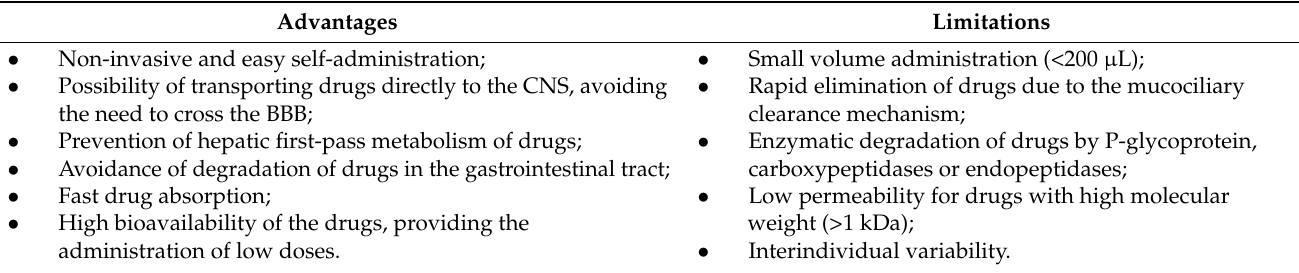
Table 2. Main advantages and limitations of the intranasal route.